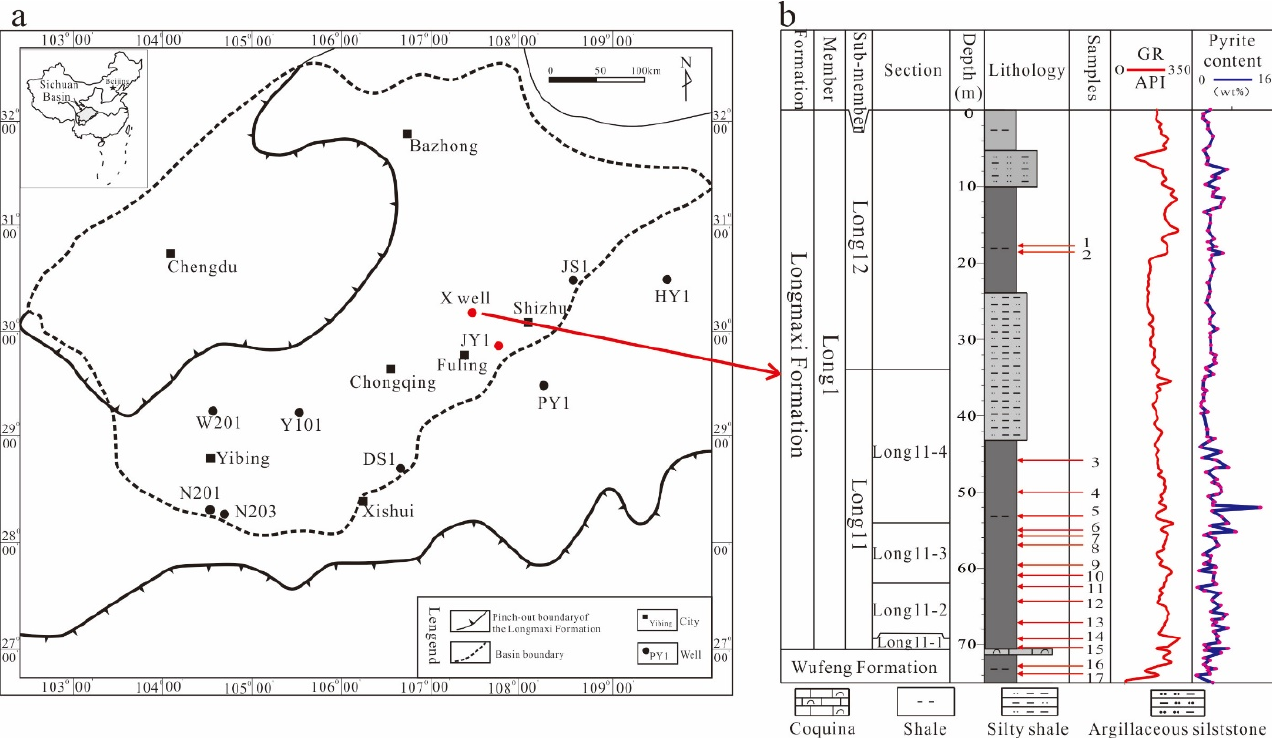
Figure 1. ( a ) Well location [22]. ( b ) The stratigraphic framework for the Upper Ordovician Wufeng Formation to the Lower Silurian Longmaxi Formation and the sampling location of the X well in the southeast Sichuan Basin.